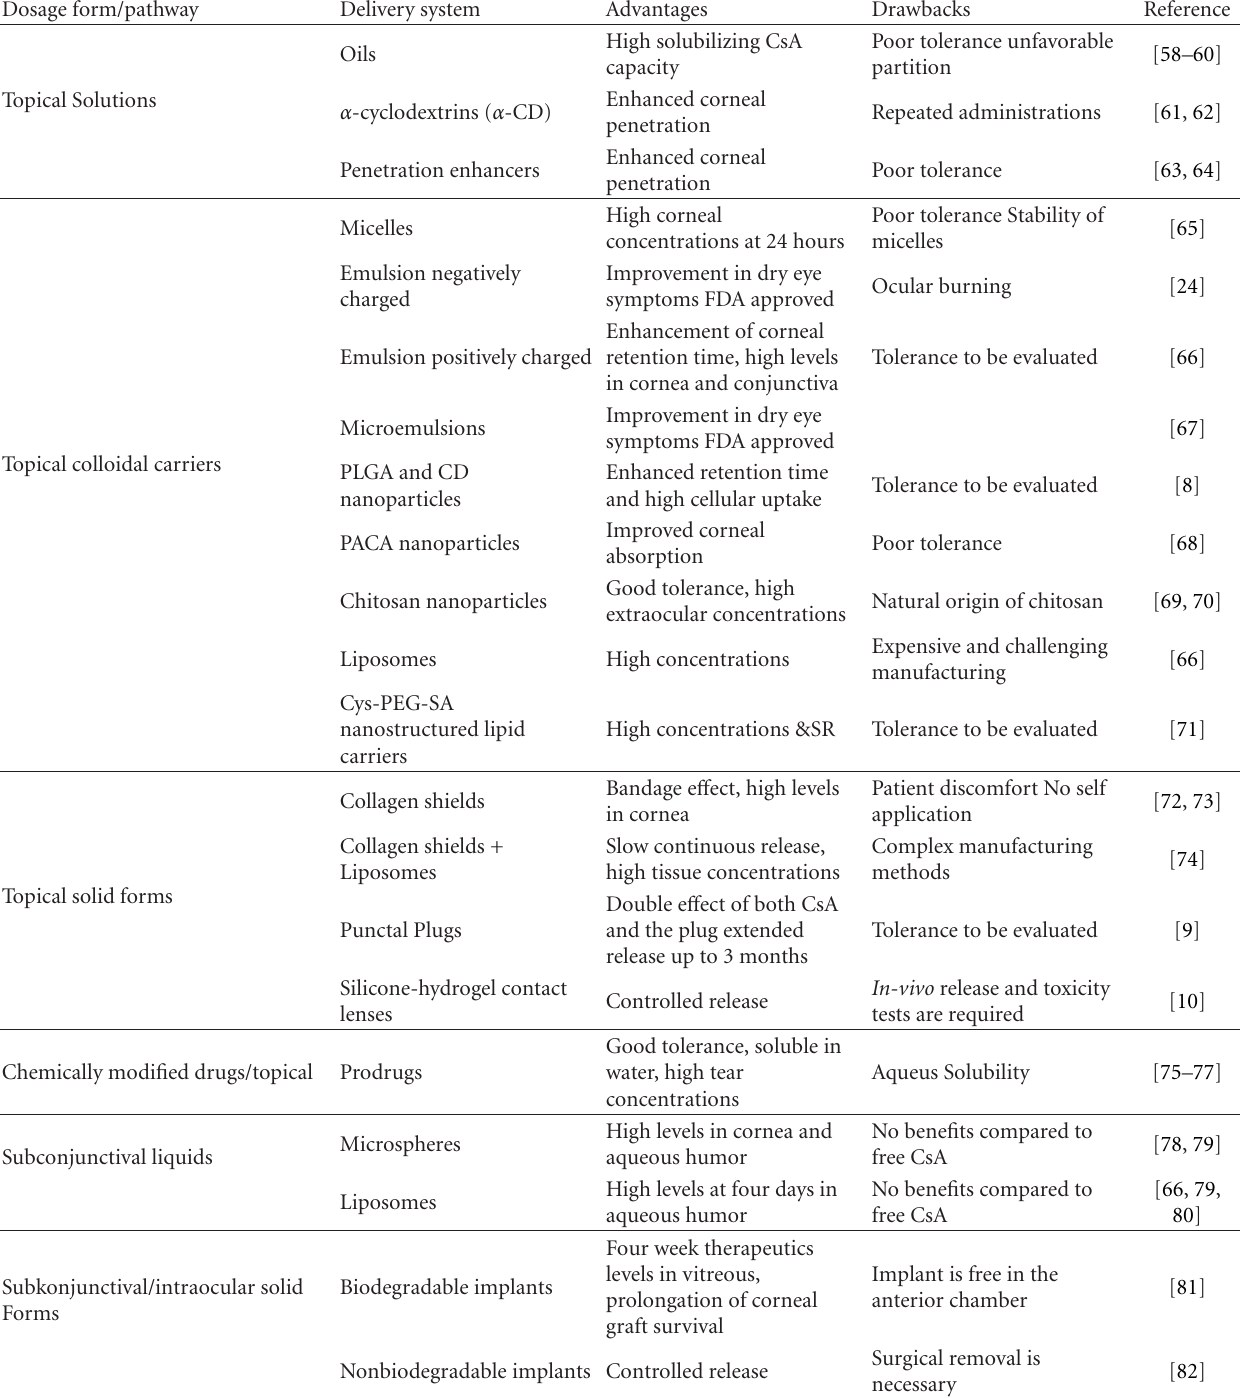
Table 1: Delivery systems developed for CsA delivery to the